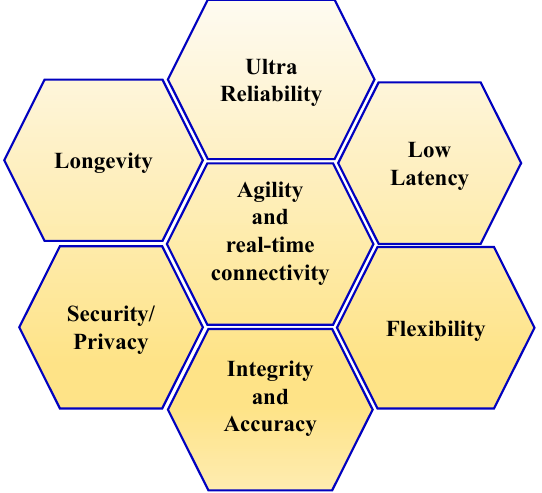
Figure 2. Key performance indicators for Industry 4.0 and beyond communication.